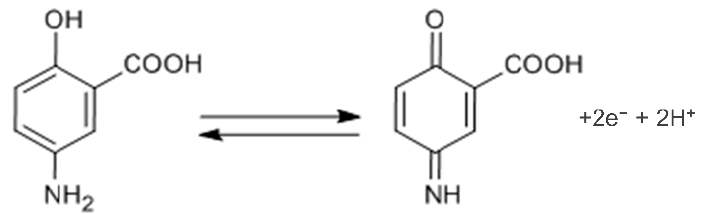
Figure 2. Differential pulse voltammograms DPVs ( v = 4 mV s − 1 ) of 50.0 µM 5-ASA in 0.04 M BR. ( a ) With glassy carbon electrode (GCE) in buffer solution from pH 2.0 to 8.0; ( b ) With different electrode architectures in buffer solution at pH 7.0. Effect of pH on 50.0 µM 5-ASA oxidation peak current, j pa (µA cm − 2 , ● ) and peak potential, E pa (V, ● ) with ( c ) GCE and ( d ) PMB DES /GCE,